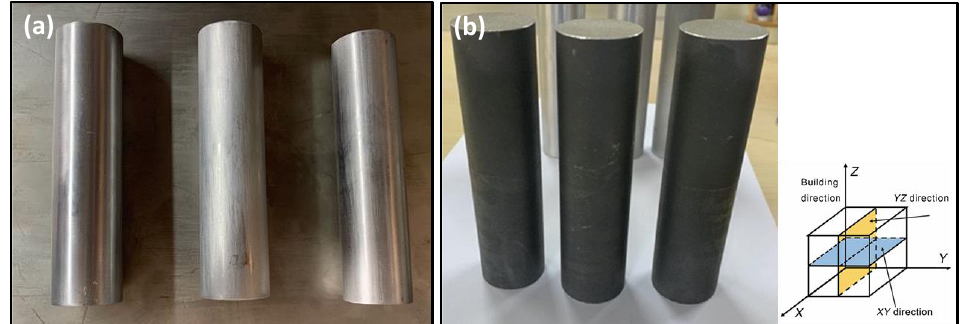
Figure 1. Pictures of the cylindrical AlSi10Mg samples: ( a ) GC (Gravity Casting) samples; ( b ) LPBF (Laser-based Powder Bed Fusion)